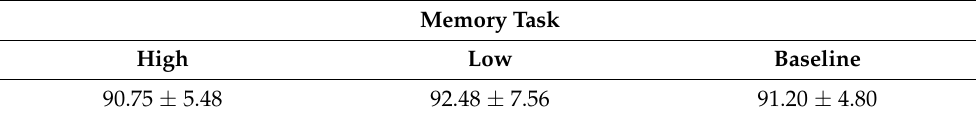
Table 1. Memory accuracies (%) by condition (M ± SDs).